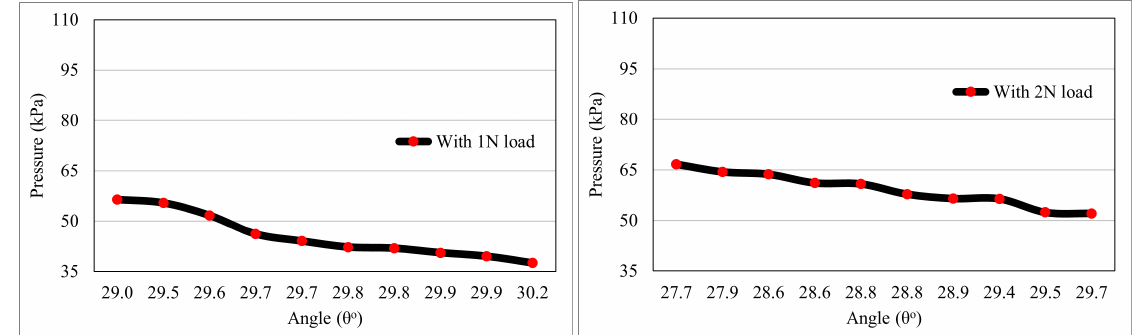
Figure A1. The observed data, showing the co-relation between pressure and angle at 1 N–2 N